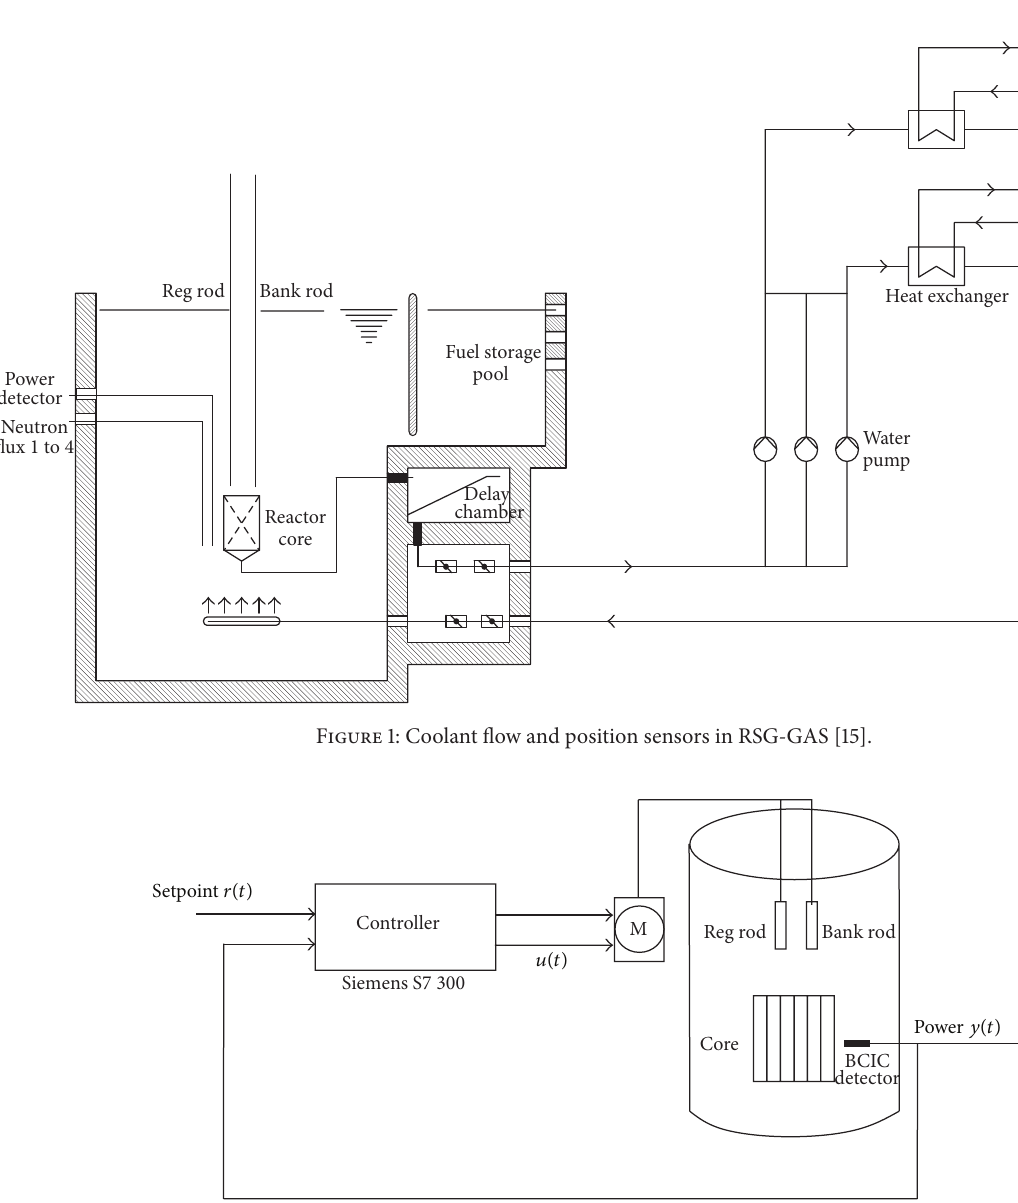
Figure 2: Block diagram of the RSG-GAS power level